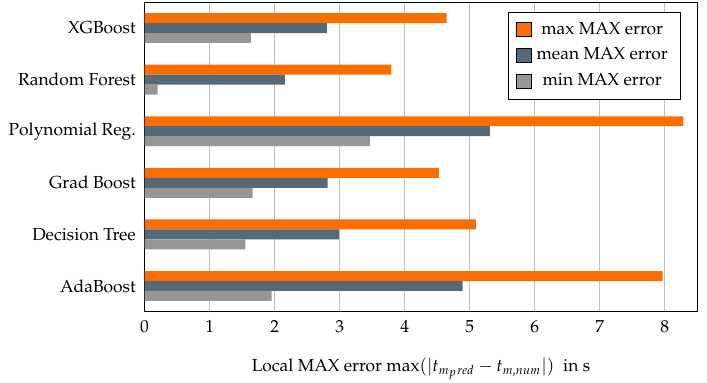
Figure 6. Comparison of local errors (MAX error) for all examined methods for the rib